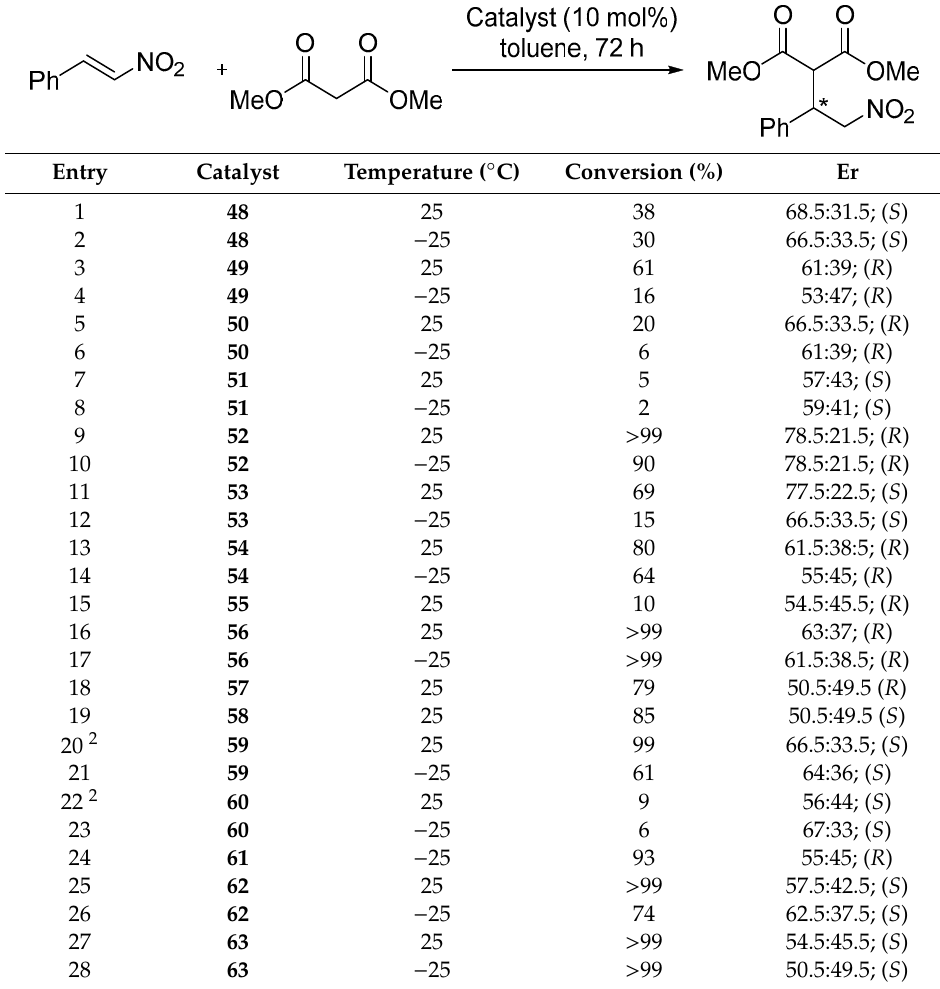
Table 1. Catalytic activity of camphor-diamine derived noncovalent bifunctional thiourea organocatalysts 48 - 63 in 1,4-additions of dimethyl malonate to trans - β -nitrostyrene.